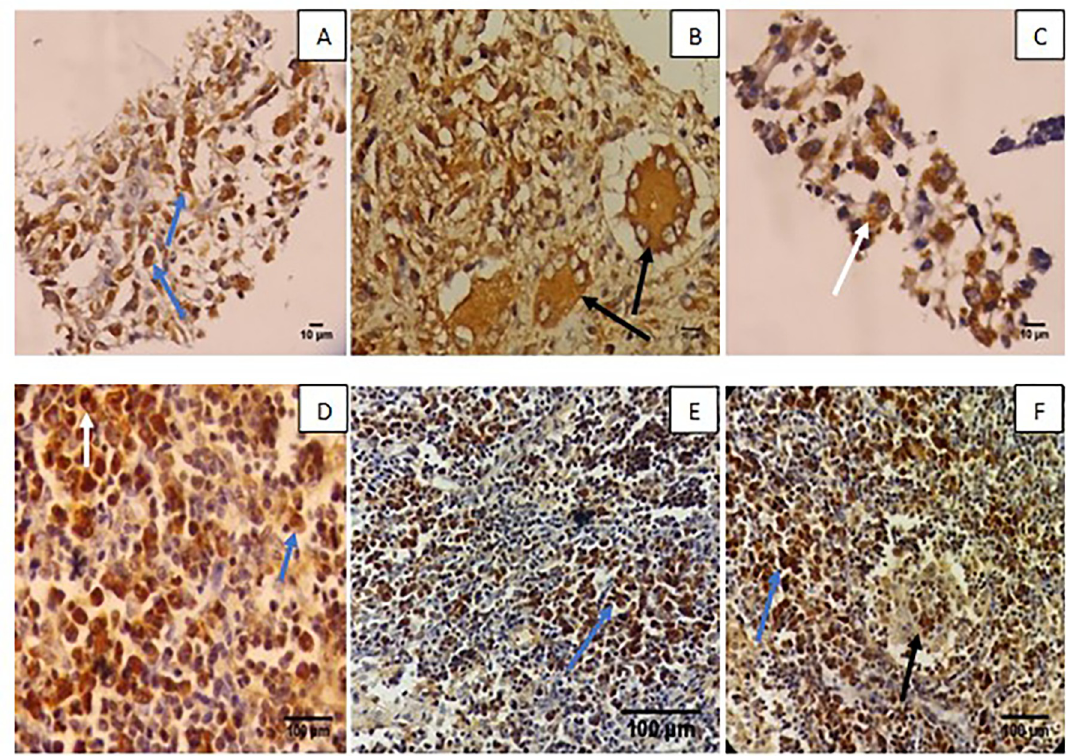
Fig 3. Immunohistochemical staining of cell block sections (A, B, C), and biopsy sections (D,E,F) by anti-MPT64 antibodies. A-C; Cytoplasmic staining of MPT64 in epithelioid cells (blue arrow), multinucleated giant cells (black arrow), and macrophages (white arrow). D-F; Cytoplasmic staining of MPT64 in epithelioid cells (blue arrow), macrophages (white arrow), and multinucleated giant cells (black